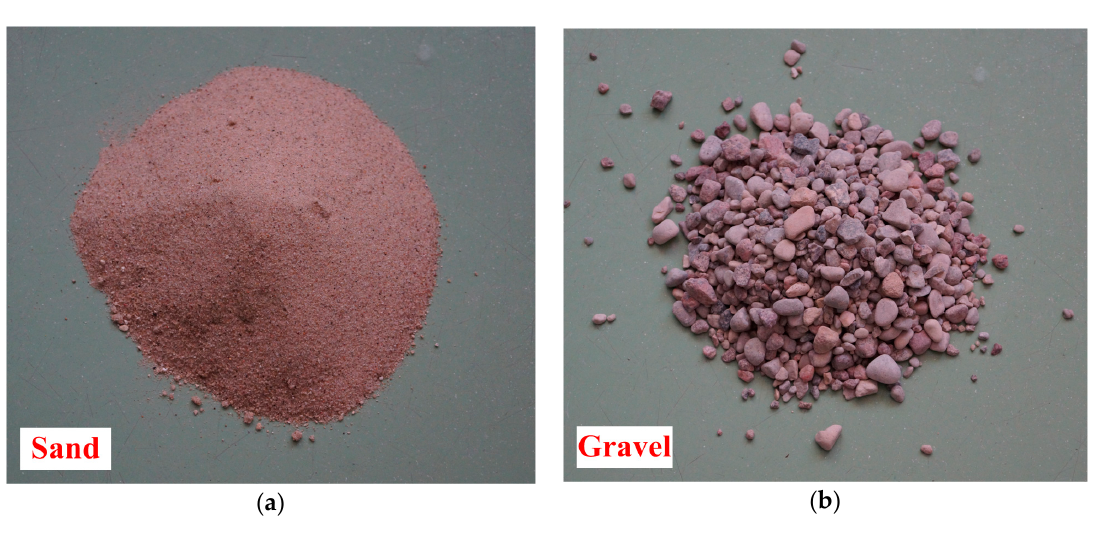
Table 3. Concrete mix design (kg/m 3 ).